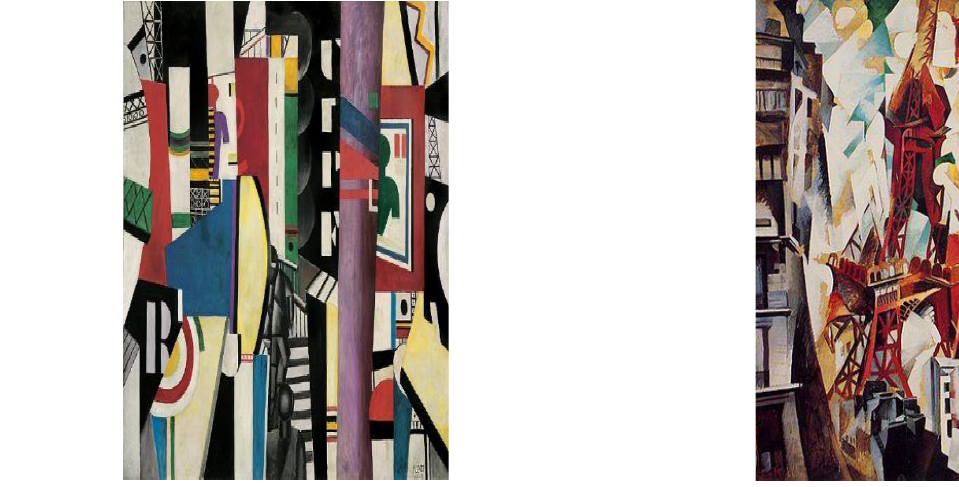
Fig. 13 the City (La Ville), 1919 oil on canvas, 231.1 x 298.4 cm Fig. 14 The Red Tower 1911-160.7 x 128.6 cm